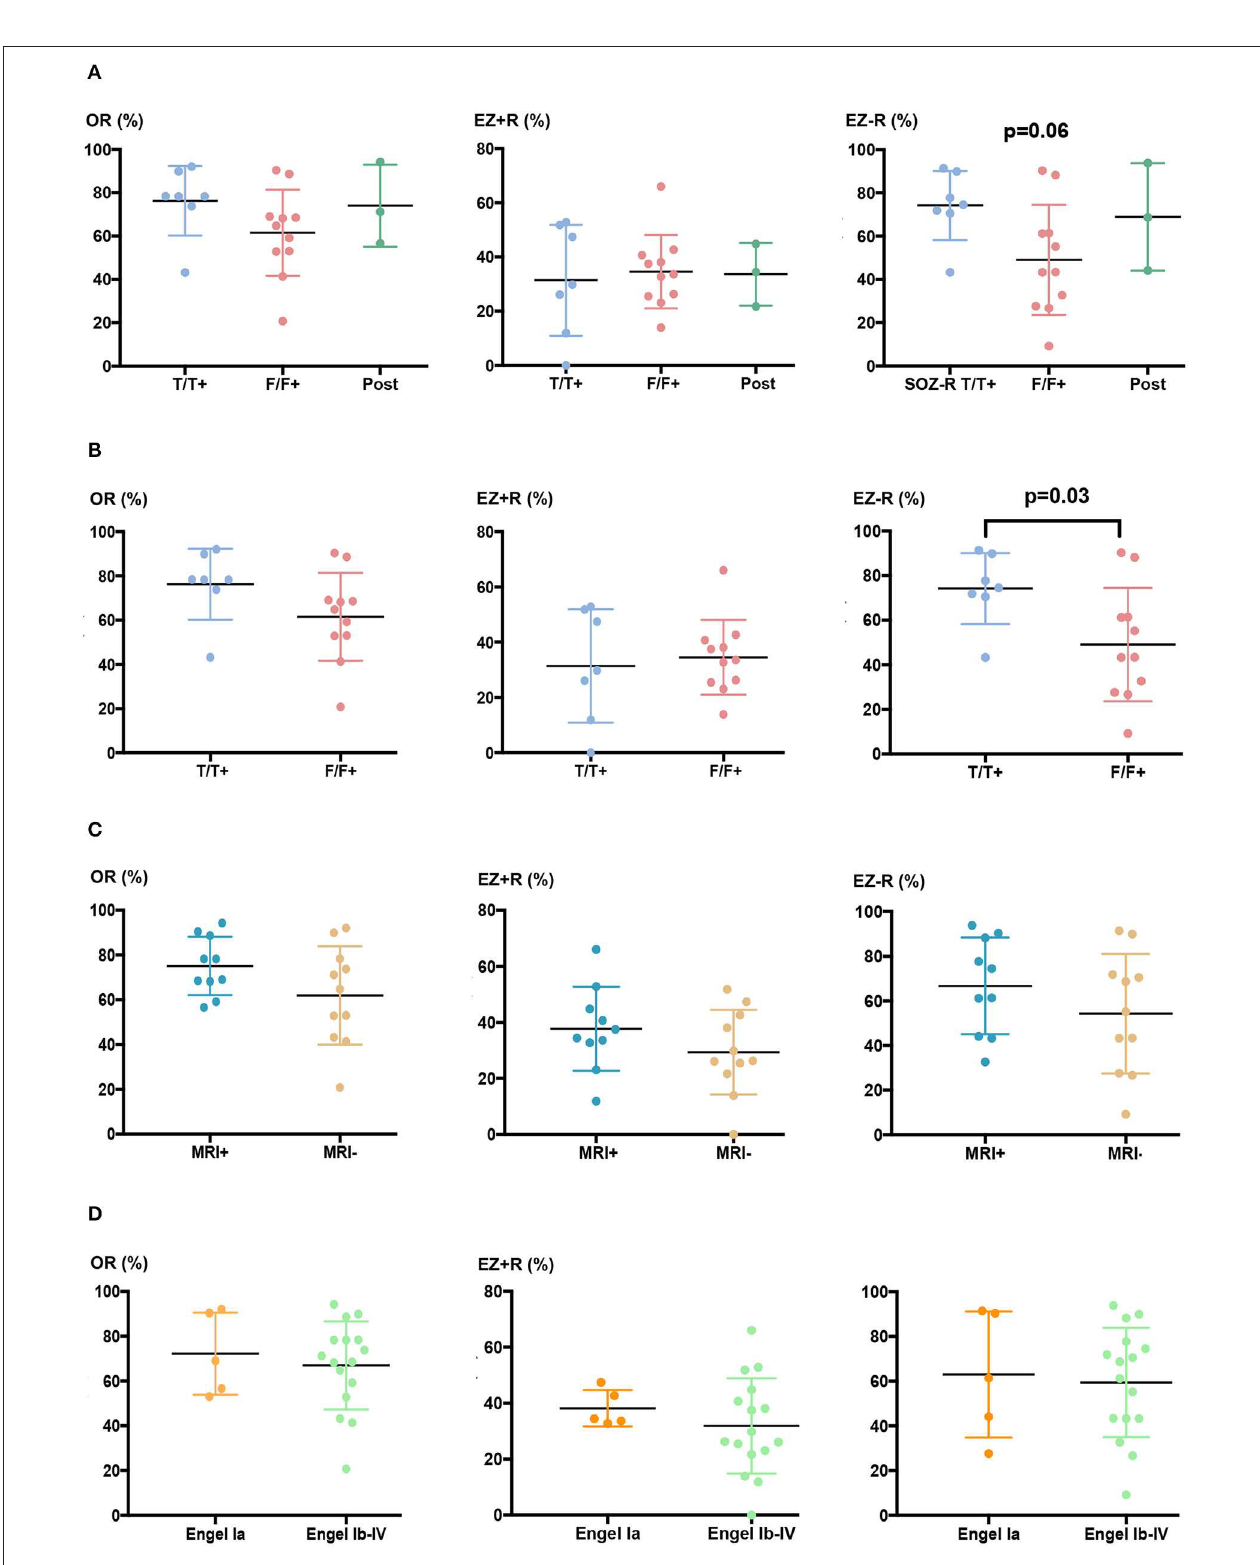
FIGURE 3 | Overlap ratios between visual and quantitative analysis depending on the epilepsy type and surgical outcome. (A) Global overlap ratio betweenthetwomethods(OR,left)andtheirconcordancetodefinetheEZ(EZ +